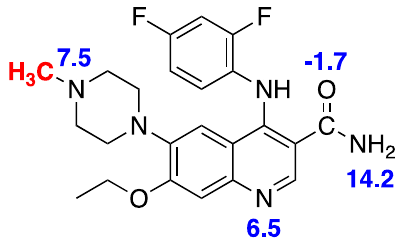
Figure 3. Multiple pKa values for AZ683 [32].